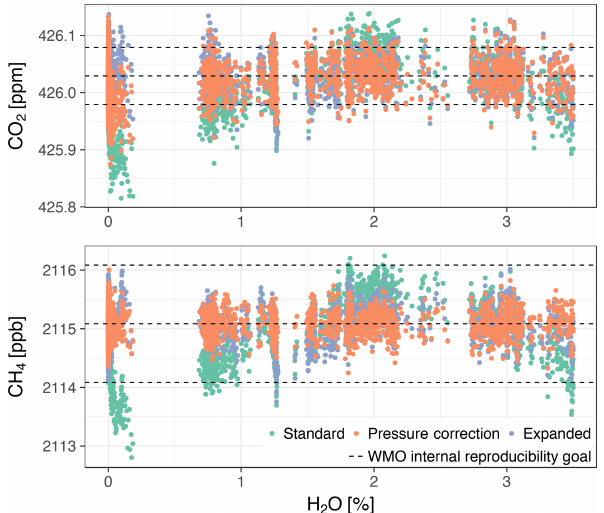
Figure 10. Dry air mole fractions from droplet experiment 1 with Picarro no. 1 based on the three water correction models. Droplet 1 is shown because it yielded the most data points after applying the filters described in the text. The dashed lines are the same as in Fig. 7.